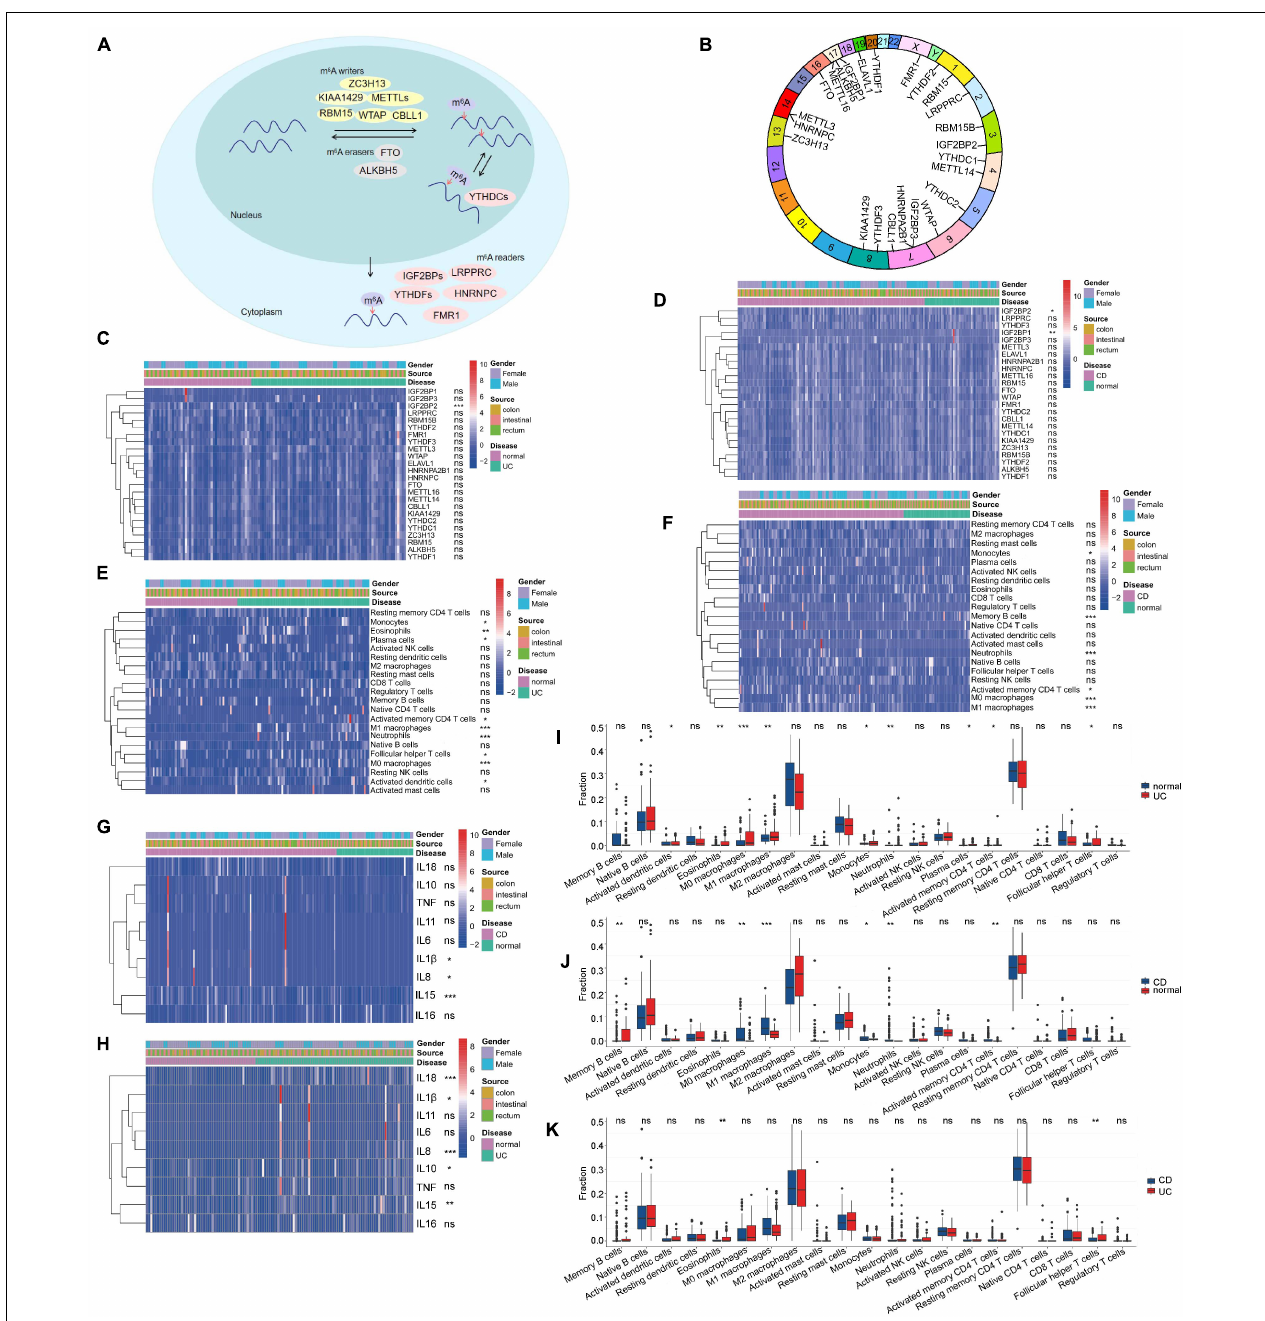
FIGURE 1 | Landscape of m 6 A regulators and immune microenvironment in inflammatory bowel disease (IBD). (A) Summary of the reversible process of m 6 A regulator–mediated methylation. (B) The location of m 6 A regulators on 24 chromosomes using GSE111889 cohort. (C,D) The expression of 24 m 6 A regulators among ulcerative colitis (UC) panel (C) , Crohn’s disease (CD) panel (D) , and normal tissues. (E,F,I–K) The difference of immune cell infiltration among UC, CD, and normal tissues. (G,H) The expression of inflammatory factors among normal, UC panel (H) , and CD tissues panel (G) . The asterisks represented the statistical P -value (* P < 0.05; ** P < 0.01; *** P <